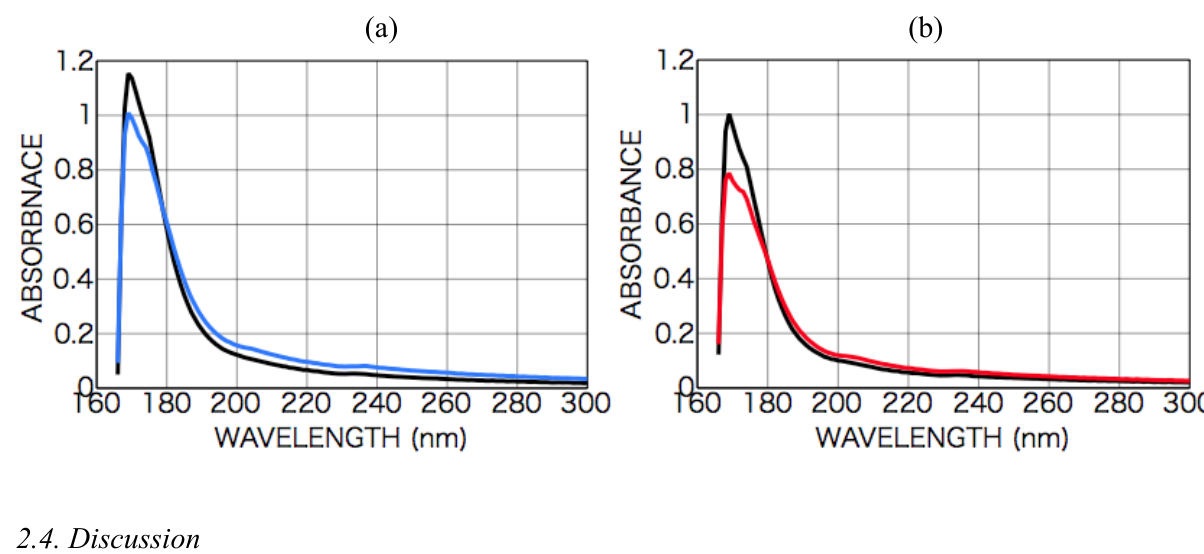
Figure 13. Photo absorption spectra of DL -isovaline films as-deposited (black) and after CPL irradiation (colored). (a) Left-handed CPL (blue); (b) Right handed CPL